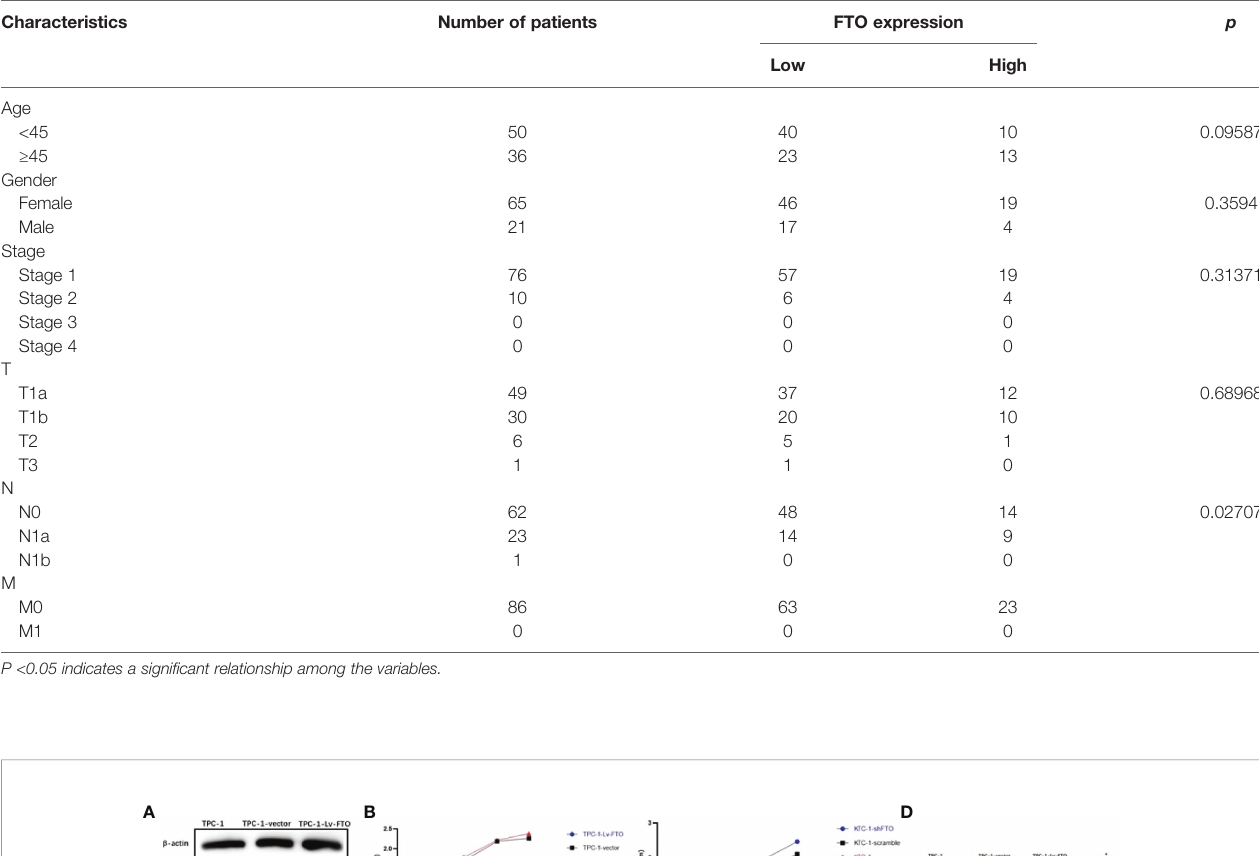
TABLE 1 | Correlation between fat mass and obesity-associated protein (FTO) expression and the clinicopathological features of papillary thyroid carcinoma. Characteristics